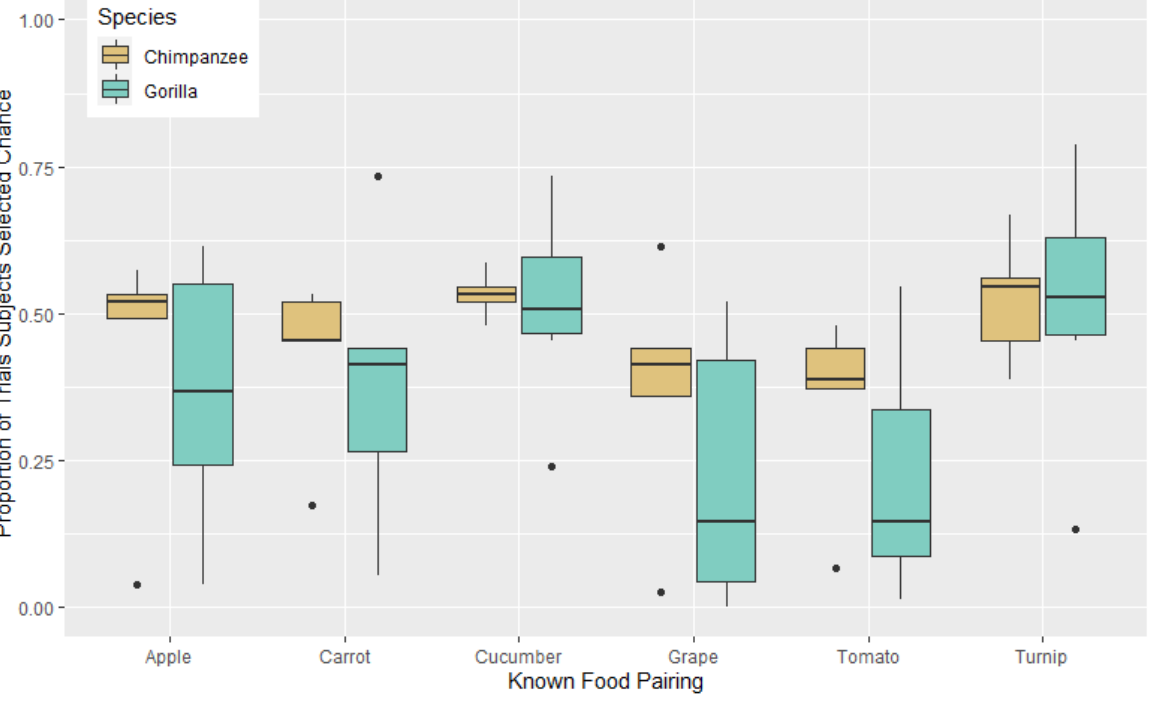
Note. Average and median proportions are shown for each food pairing presented in Phase 2. The top and bottom whiskers indicate the maximum and minimum proportion values, respectively, excluding outliers, which are represented by